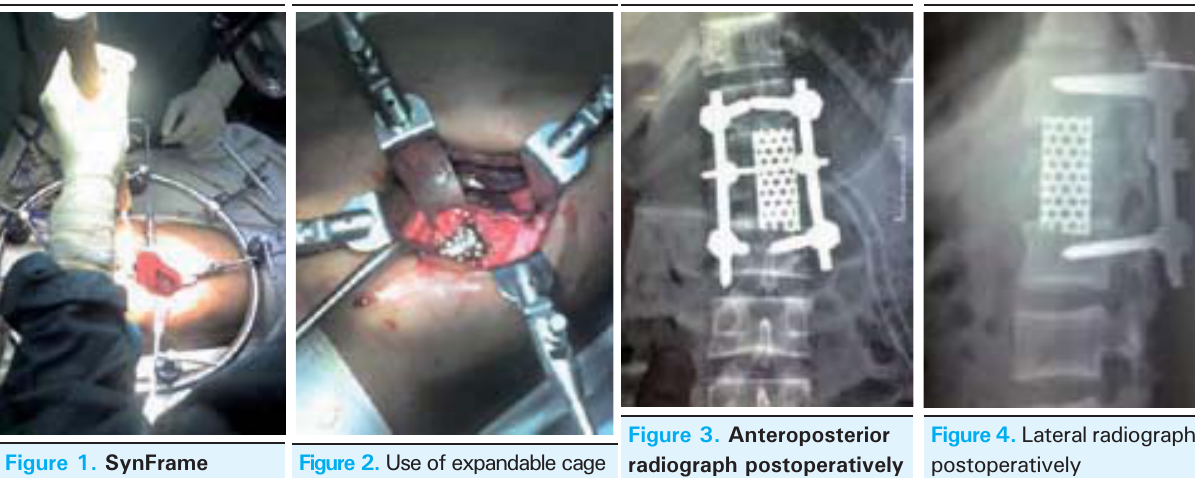
Figure 4. Lateral radiograph Figure 3. Anteroposterior radiograph postoperatively